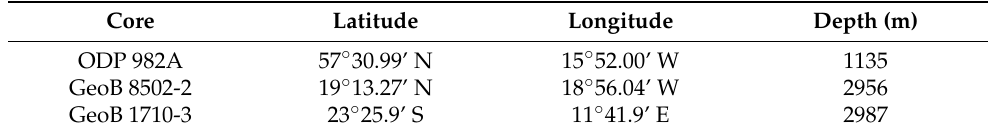
Table 1. List of the core